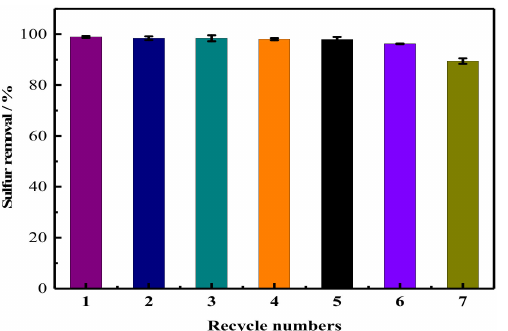
Figure 9. Desulfurization efficiency of recycling system. Reaction conditions: V(oil) = 5 mL; n(catalyst)/n(S) = 0.025; n(H 2 O 2 )/n(S) = 6; t = 60 min; T = 50 ◦ C; V(acetonitrile) = 0.5